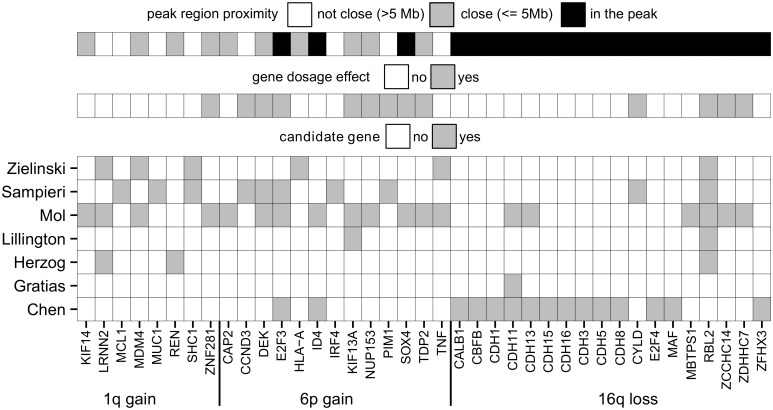
Reported candidate genes.Overview of putative candidate genes proposed by previous studies for commonly gained chromosomal arms 1q and 6p and commonly lost 16q.